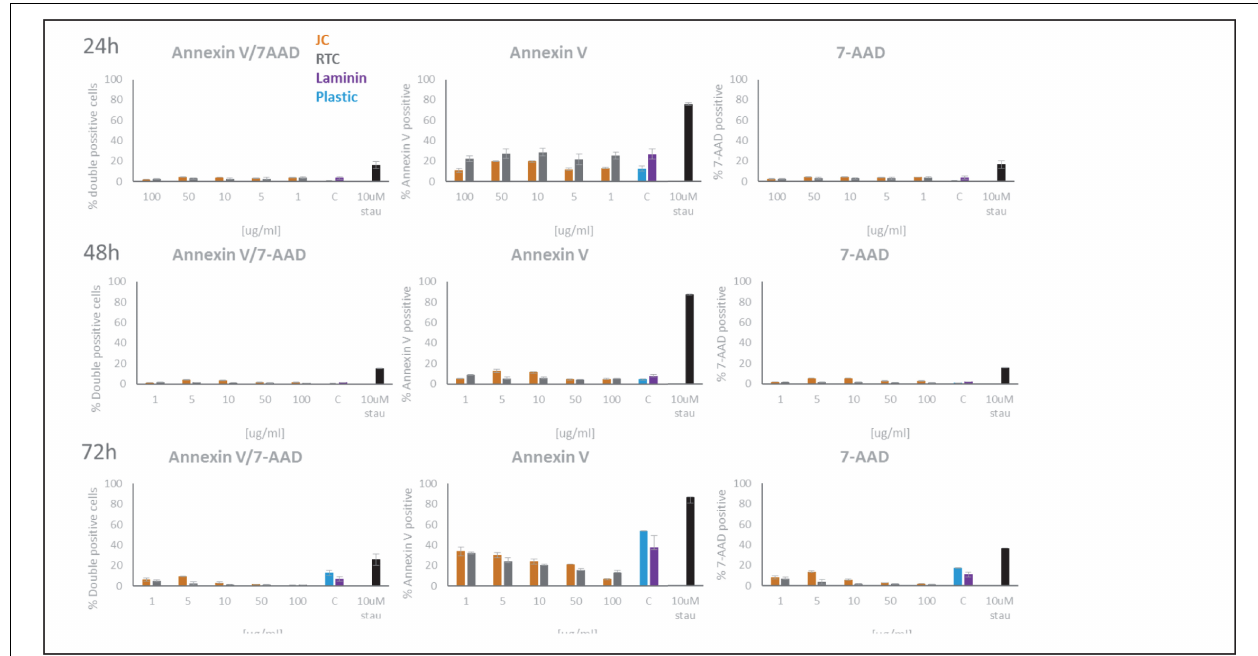
FIGURE 3 | Quantification of Annexin V and 7-AAD staining of microglia following culture on JC, RTC, laminin, or plastic for 24, 48, or 72 h. A positive control of cell death was included by incubating cells with 10 µ M Staurosporine for 2 h prior to staining. Data shown are the mean of 3 technical repeats ±